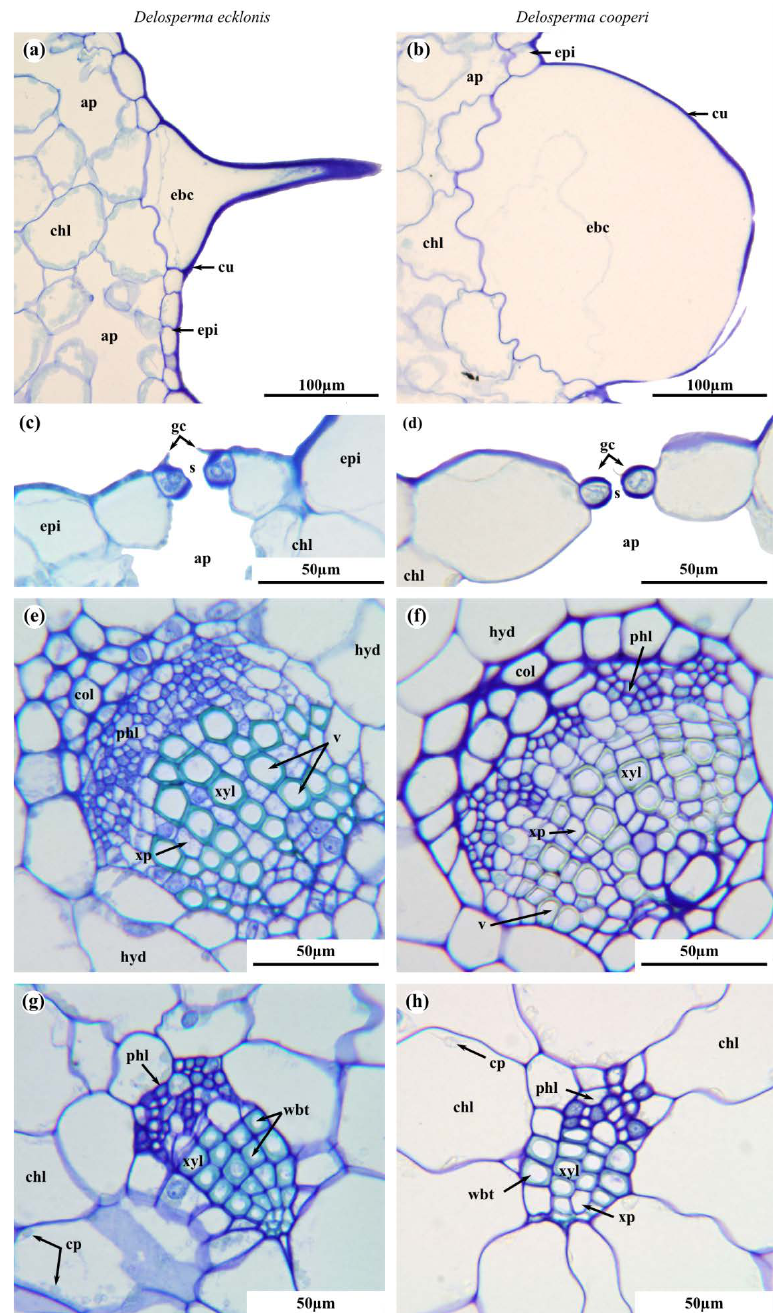
Figure 3. Comparison of epidermal idioblasts and the vasculature of the leaves of D. ecklonis ( a , c , e , g ) and D. cooperi ( b , d , f , h ). ( a ) Basally thickened and distally elongated (trichome-like) epidermal bladder cell (ebc) of D. ecklonis . ( b ) Epidermal bladder cells (ebc) of D. cooperi are large and rounded. Longitudinal section of a stoma (s) of D. ecklonis ( c ) and D. cooperi ( d ) with guard cells (gc) and air pockets (ap). Central vascular strand of D. ecklonis ( e ) and D. cooperi ( f ) with angular collenchyma (col) cap on the phloem (phl) side of the bundle. ( g ) Peripheral vascular bundles of D. ecklonis are located in close proximity to the chlorenchyma (chl) and are characterized by wide-band tracheids (wbt). ( h ) Wide-band tracheids are also found in peripheral vascular bundles of D. cooperi . ap: air pocket; chl: chlorenchyma; col: collenchyma; cp: chloroplast; cu: cuticula; ebc: epidermal bladder cell; epi: epidermis; gc: guard cell; hyd: hydrenchyma; phl: phloem; s: stoma; t: trichome; v: vessel element; wbt: wide-band tracheids; xp: xylem parenchyma; xyl: